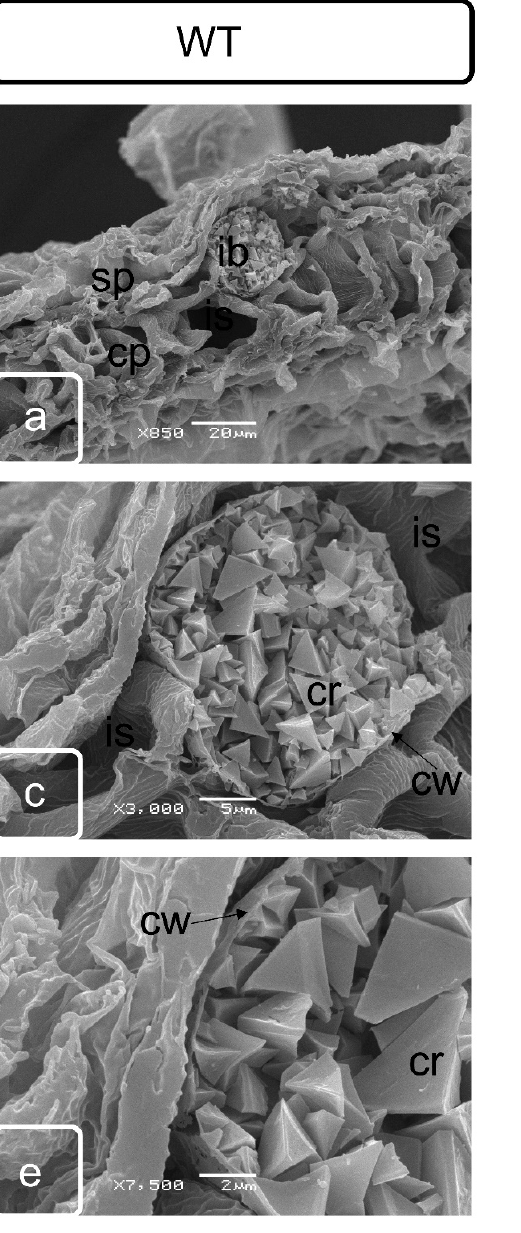
Figure 5. Scanning electron microscopy of spongy parenchyma cells of leaves of WT ( a , c , e , g ) and transgenic plants ( b , d , f , h ) from young ( a – d ) and mature ( e – h ) leaves. Ib—idioblast; sp—spongy parenchyma cells; cp—columnar parenchyma cells; cr—crystals of calcium oxalate; cw—cell wall; pl—plastids; is—intercellular space.